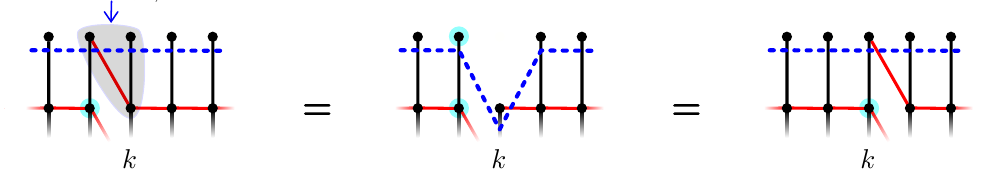
Figure 8 . Graphical representation of the action of the operator h (cid:0) 1 stretched horizontally between the k +1 and k sites. It can be interpreted as an operator annihilating a magnon and anti-magnon situated at two neighbouring sites.